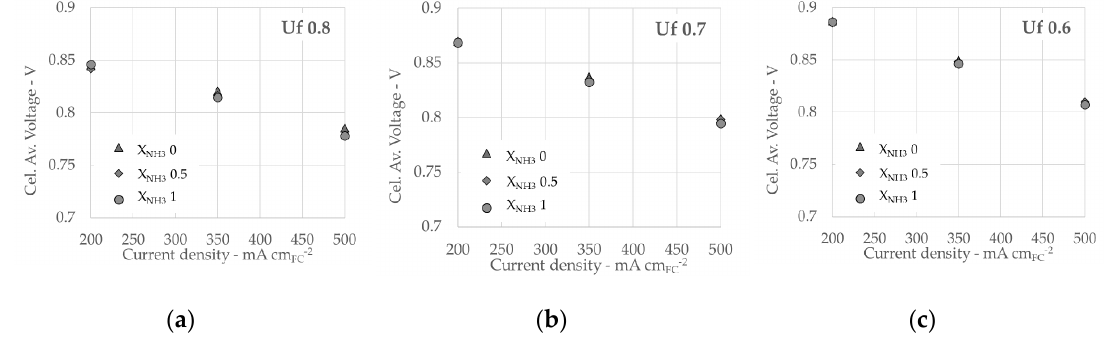
Figure 5. Stack test results at 750 °C for Uf 0.8 ( a ), Uf 0.7 ( b ) and Uf 0.6 ( c ).